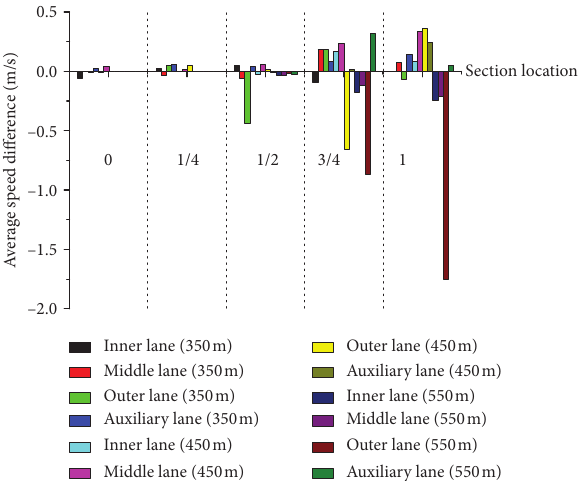
Figure 9: The acceleration range difference between the optimized method and the original design.